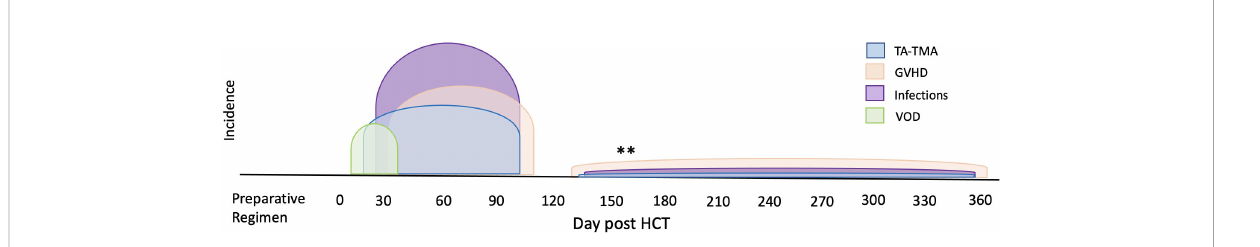
FIGURE 4 Overlap of TA-TMA and common post-BMT complications in time. The typical high-risk period for complications post-HCT are indicated in different colors. The high-risk period for TA-TMA overlaps with the risk period for acute GVHD, VOD, infections, and organ toxicities such as pulmonary failure. **Often in the setting of overlapping or chronic GVHD, increased risks for infections and TA-TMA can occur later in the transplant course.